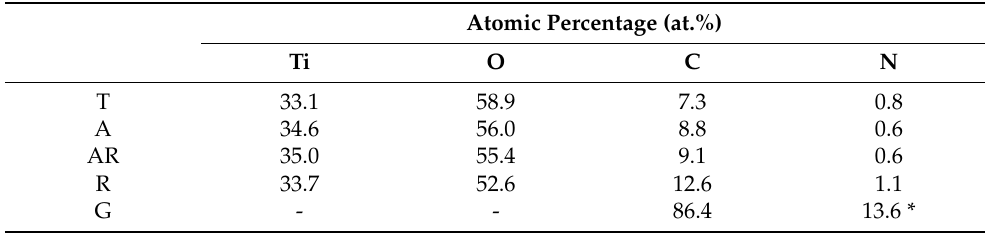
Table 2. XPS analysis results, in terms of elemental composition, of FXIIa from coagulation on the surfaces of test specimens.